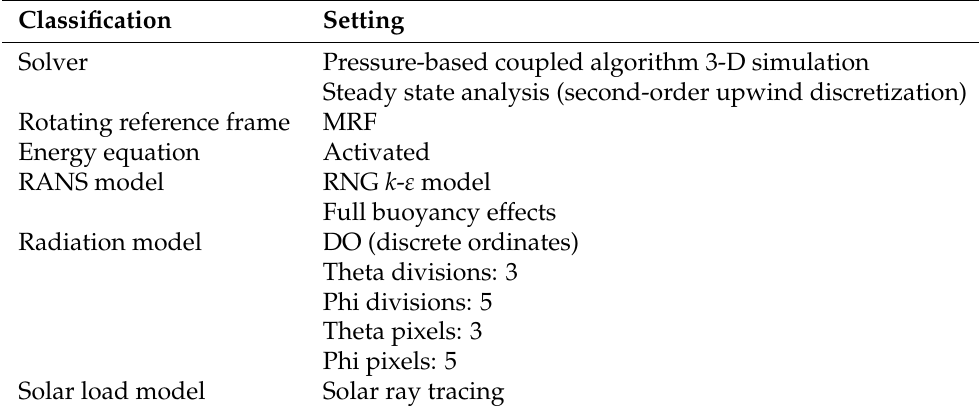
Table 3. Basic settings of the CFD simulation.